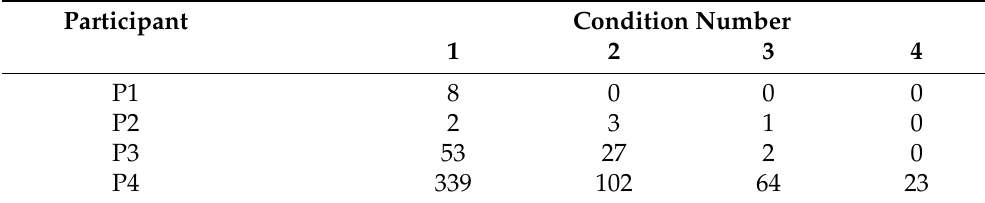
Table 5. Onsets per condition, sorted by sequence order. Condition number 1 corresponds to the first condition that the students were exposed to, whereas condition number 4 corresponds to the last